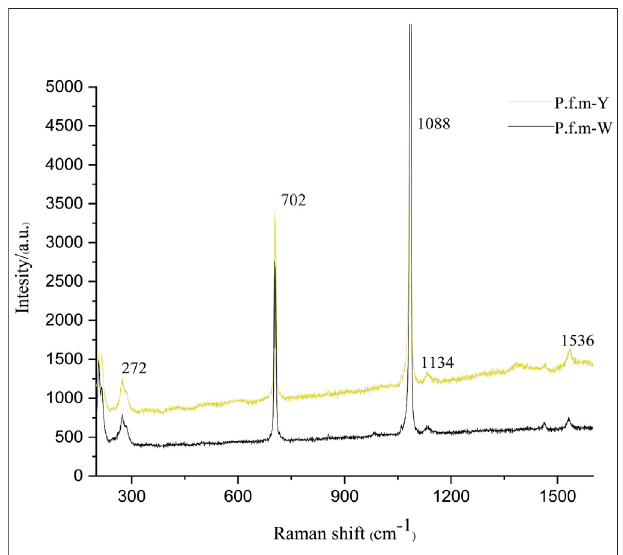
FIGURE 2 | Raman spectra of nacre of Pinctada fucata martensii